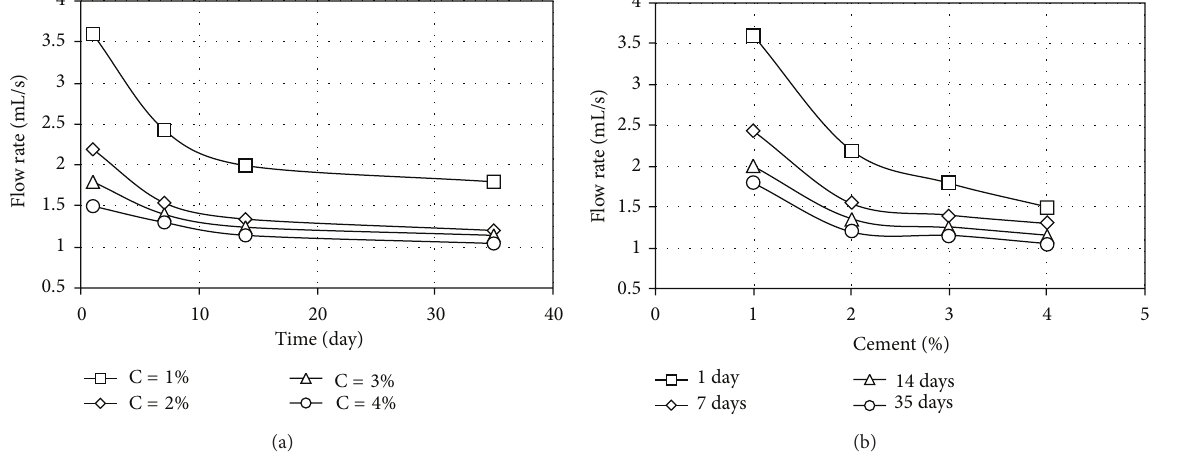
created in samples, with given hydraulic head. The summary of results and, categorization of treated specimens are given in Table